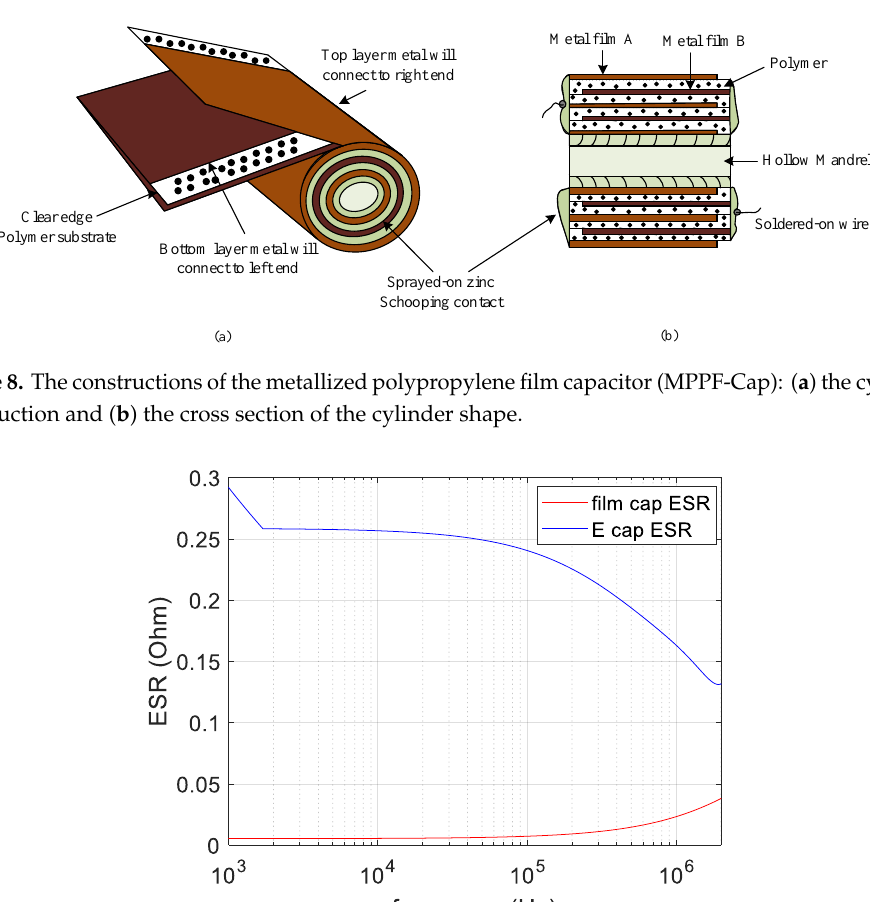
Figure 9. Frequency characteristics of ESR values of the electrolytic and film capacitors used in DC capacitor of VSI in electric compressor systems.